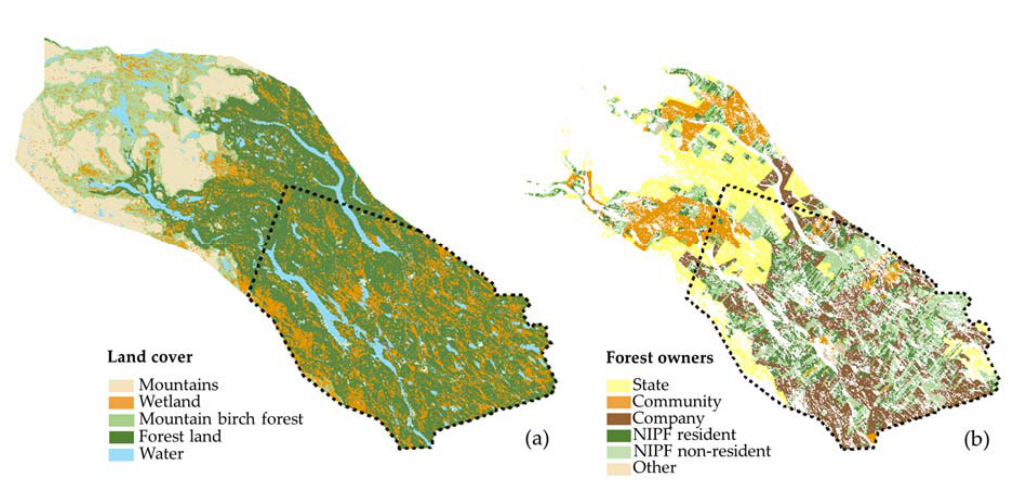
Figure 4. Maps of Vilhelmina municipality (Sweden) illustrating ( a ) major land cover types and ( b ) forest ownership patterns (as of January 2016), with a separation of resident and non ‐ resident NIPF owners. The dotted line marks our focus study area. Land ownership is categorized into State, Company (large ‐ scale forest companies), NIPF resident and NIPF non ‐ resident (non ‐ industrial private forest owners identified as living in or outside the municipality), NIPF mix (a mix of NIPF resident and NIPF non ‐ resident owners), Community (a large forest common, the municipality, and some smaller village commons), and Other (the church, foundations, and unidentified owners).